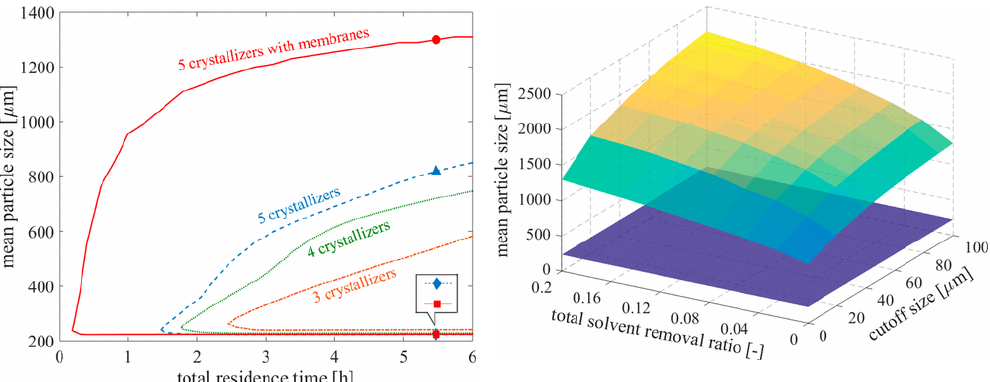
Figure 7. Attainable crystal particle size as a function of number of vessels, residence time, solvent removal ratio and cutoff size. Reproduced with permission from Wang and Lakerveld, Industrial & Engineering Chemistry Research; published by American Chemical Society, 2017 [18].